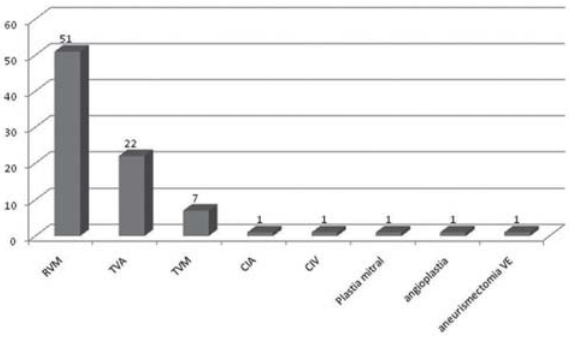
Fig. 1 - Tipo de cirurgia cardíaca